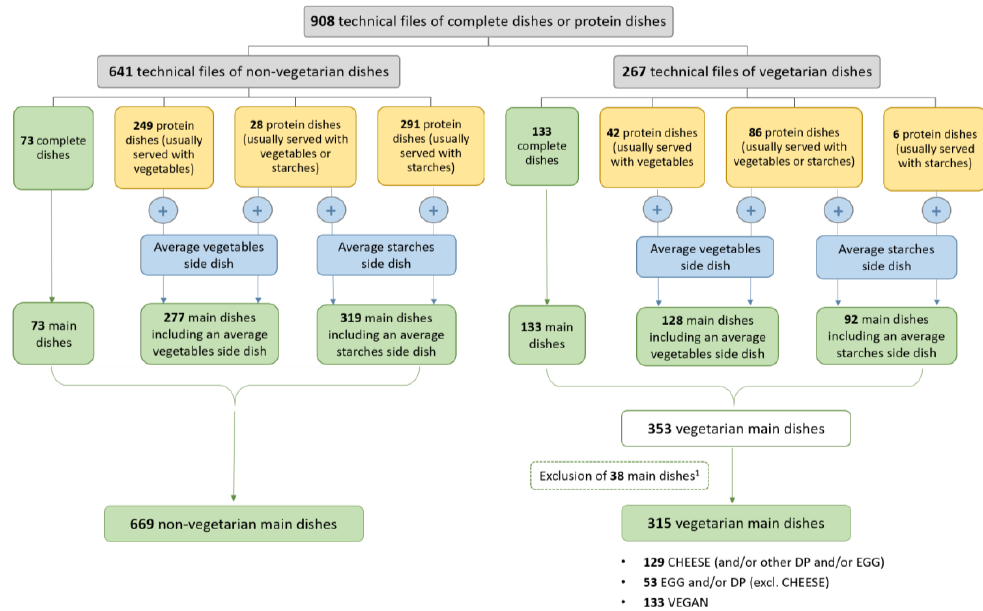
Figure 1. Overview of the distribution of main dishes according to their category (vegetarian or non- vegetarian), the type of side dish (“no side dish”, “vegetables” or “starches”) and, for vegetarian dishes, the sub-category (“CHEESE and/or DP and/or EGG”, “EGG and/or DP (excl. CHEESE)”, “VEGAN”). 1 SAIN and LIM scores were not estimated for 38 industrial main dishes because their technical file was incomplete, labelled information on nutrients was insufficient and no matching food was found in the ingredient database.